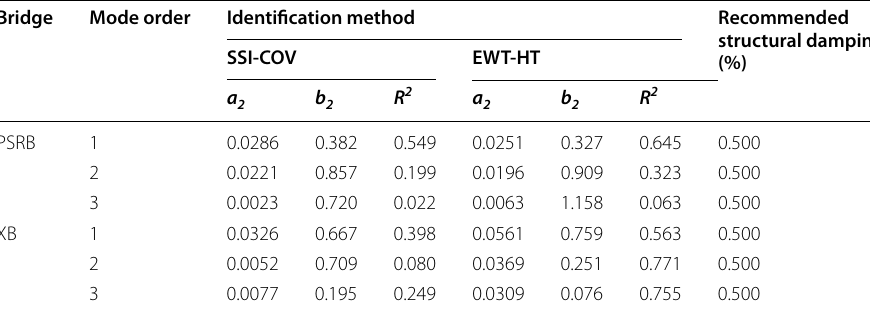
Table 2 Statistics of fitting parameters of identified modal damping ratios of PSRB and XB